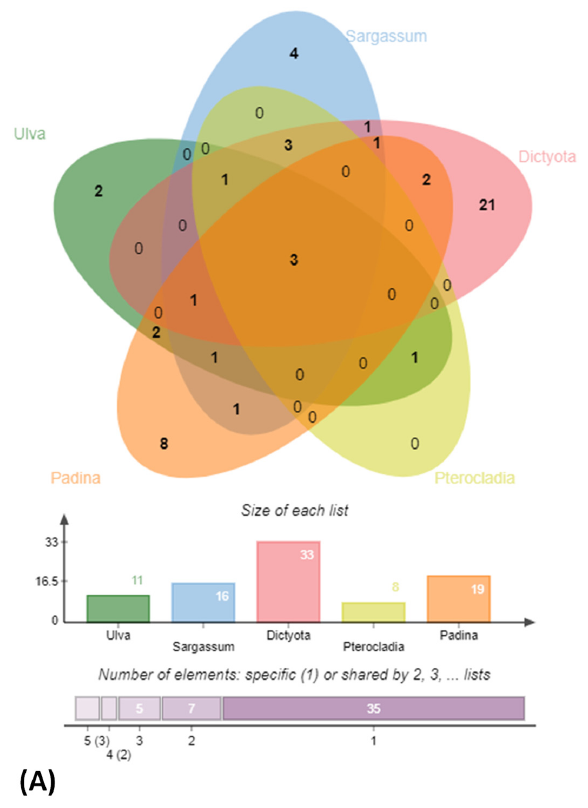
Figure 3. Stacked bar plots of ( A ) Class, ( B ) Family and ( C ) genus level distribution of microbial taxa. The percent value mentioned along with the genera name signifies abundance (mean %) among all the samples.